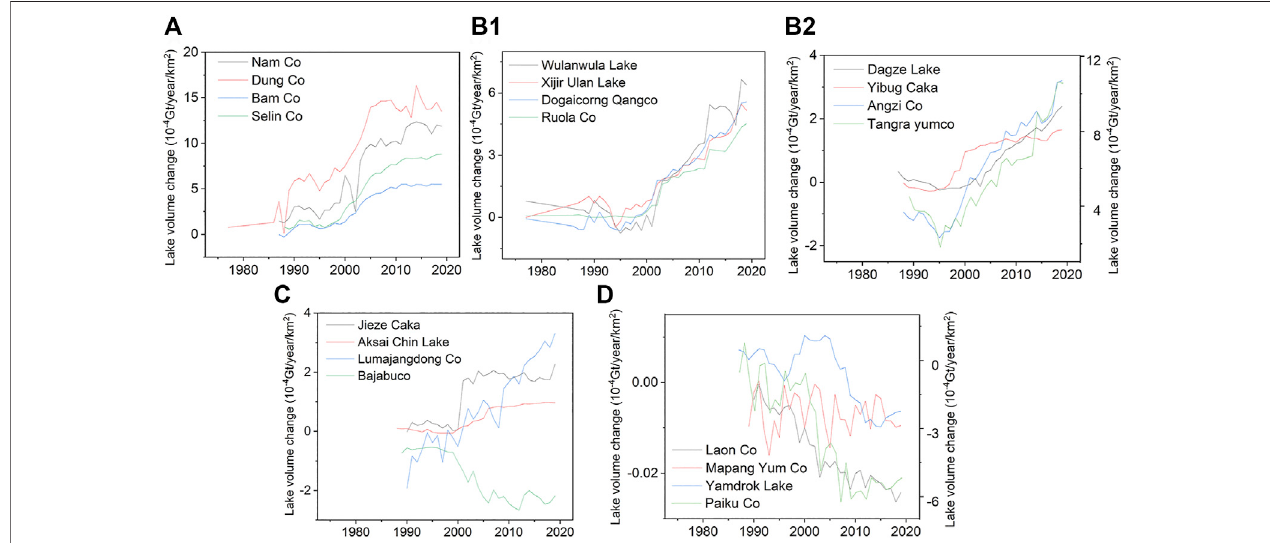
FIGURE 3 | Main types of lake volume changes in each district (vertical ordinate is the relative lake volume change, unit is 10 − 4 Gt/year/km 2 ).